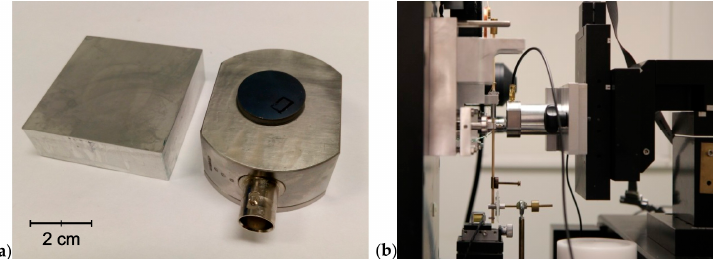
Figure 2. ( a ) Comparison of sample holders: traditional passive 5 cm × 5 cm specimen holder from duralumin (left) and the AE sample holder with built-in acoustic emission sensor and pre-amplifier (right). ( b ) Implementation of the AE holder into the NanoTest instrument.